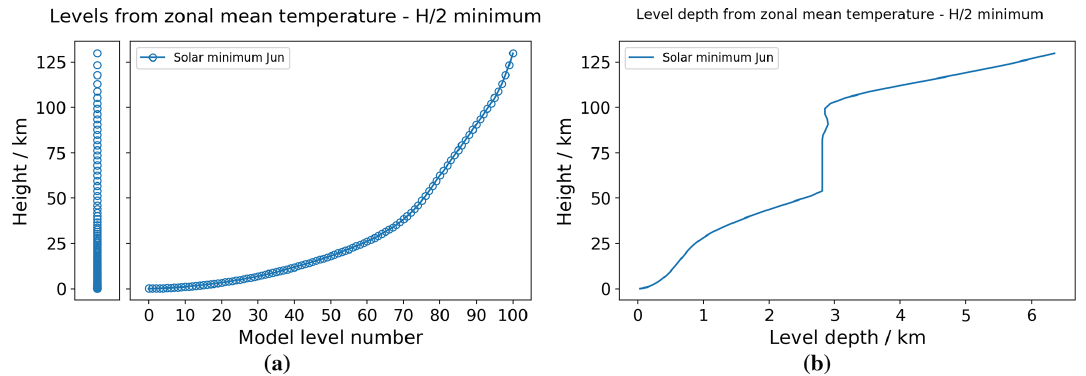
Figure 5. (a) Vertical level set and (b) corresponding level depths produced using the new implementation. The vertical level depth can be seen to be capped up to the mesopause and then increase with the increase in temperature when going up through the